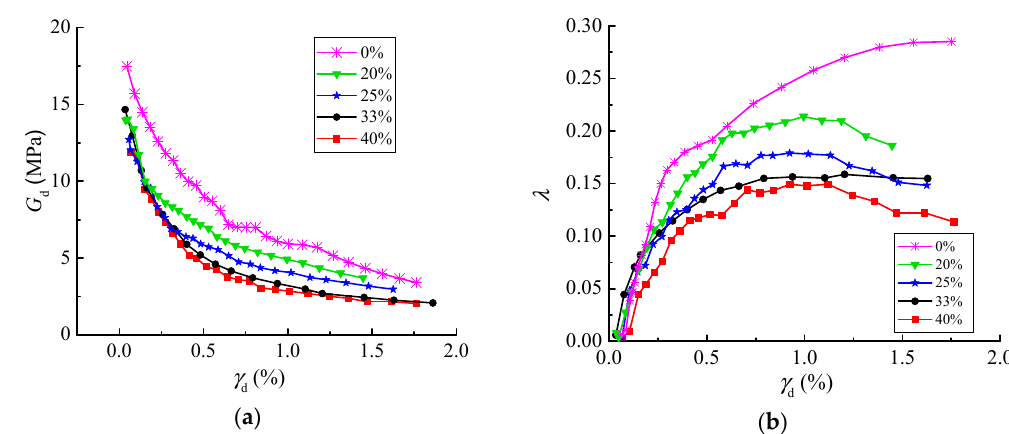
Figure 7. Shear modulus and damping ratio versus shear strain amplitude for the sand-sawdust mixture with various sawdust contents with the confining pressure of 100 kPa. ( a ) Shear modulus versus shear strain amplitude; ( b ) damping ratio versus shear strain amplitude.